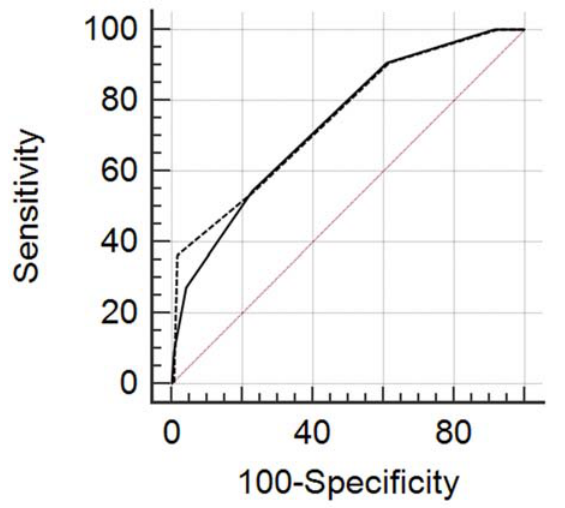
Figure 3. Overall diagnostic accuracy represented by the area under the ROC curve (AUC) ranged from 0.736 (R1—dashed line: 95% CI: 0.662 to 0.819, p = 0.0019) to 0.747 (R2—solid line: 95% CI: 0.662, p = 0.0018). There was no statistically significant difference between the two readers. Table 2. Diagnostic parameters and cut ‐ off values of the score for reader R1.